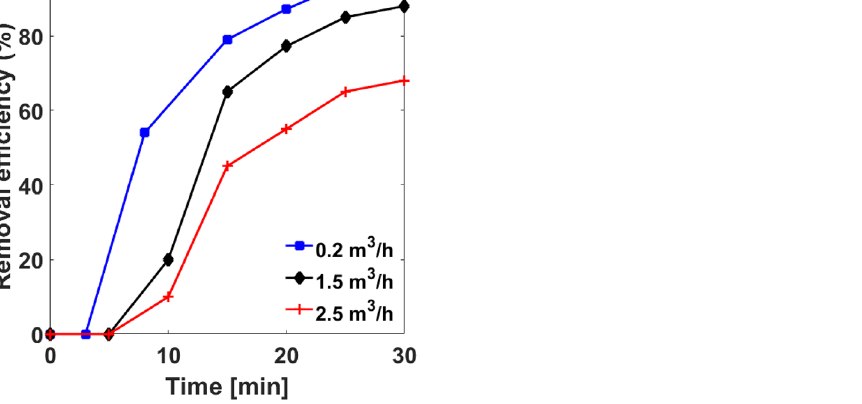
Figure 6. Effect of air stream flow rate on removal efficiency at different discharge power.